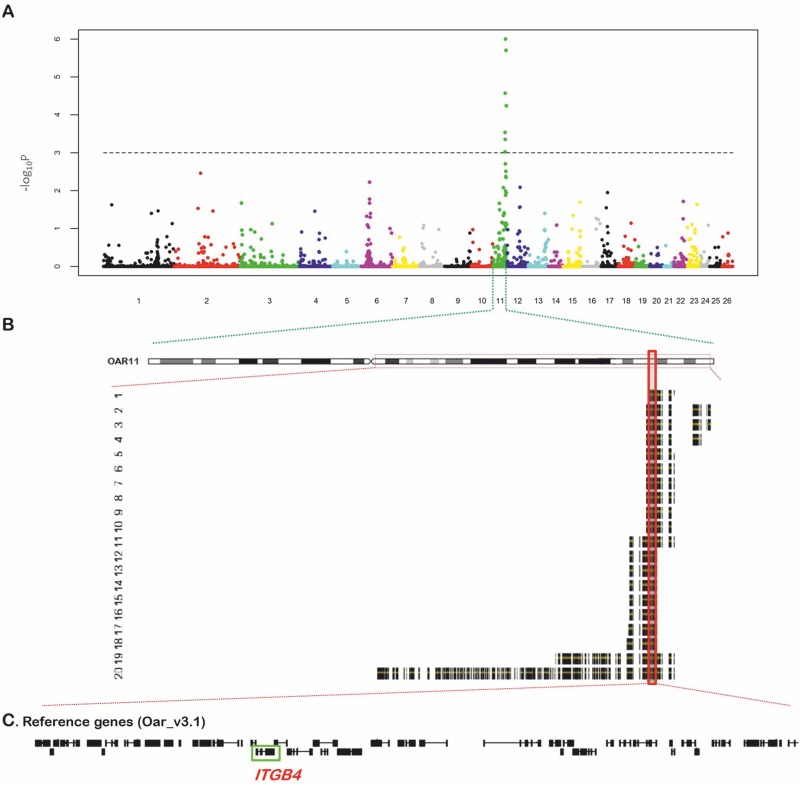
Workflow chart for the discovery of the mutant locus of inherited JEB in Churra sheep.(A) Manhattan plot that shows the results of the case-control GWA analysis performed. The X-axis shows the positions of the SNPs analyzed across the 26 ovine autosomes; different colors represent each different chromosome. The Y-axis represents the −log10P values obtained after performing 1 million permutations using PLINK. The most significant associated SNP is located at position 54,939,690 bp on OAR11. (B) IBD analysis on OAR11. The analysis of SNPs genotypes from affected lambs shows an extended homozygous region on chromosome 11. All twenty affected lambs shared overlapping homozygous blocks (black and yellow blocks, which represent the genes within the homozygous block of each animal). The consensus haplotype block (indicated by a solid red box) that contains the putative causal mutation expands a region of 868-kb, from 54,632,309–55,500,100 bp on OAR11. (C) Gene content of the 868-kb interval shared by the JEB affected.